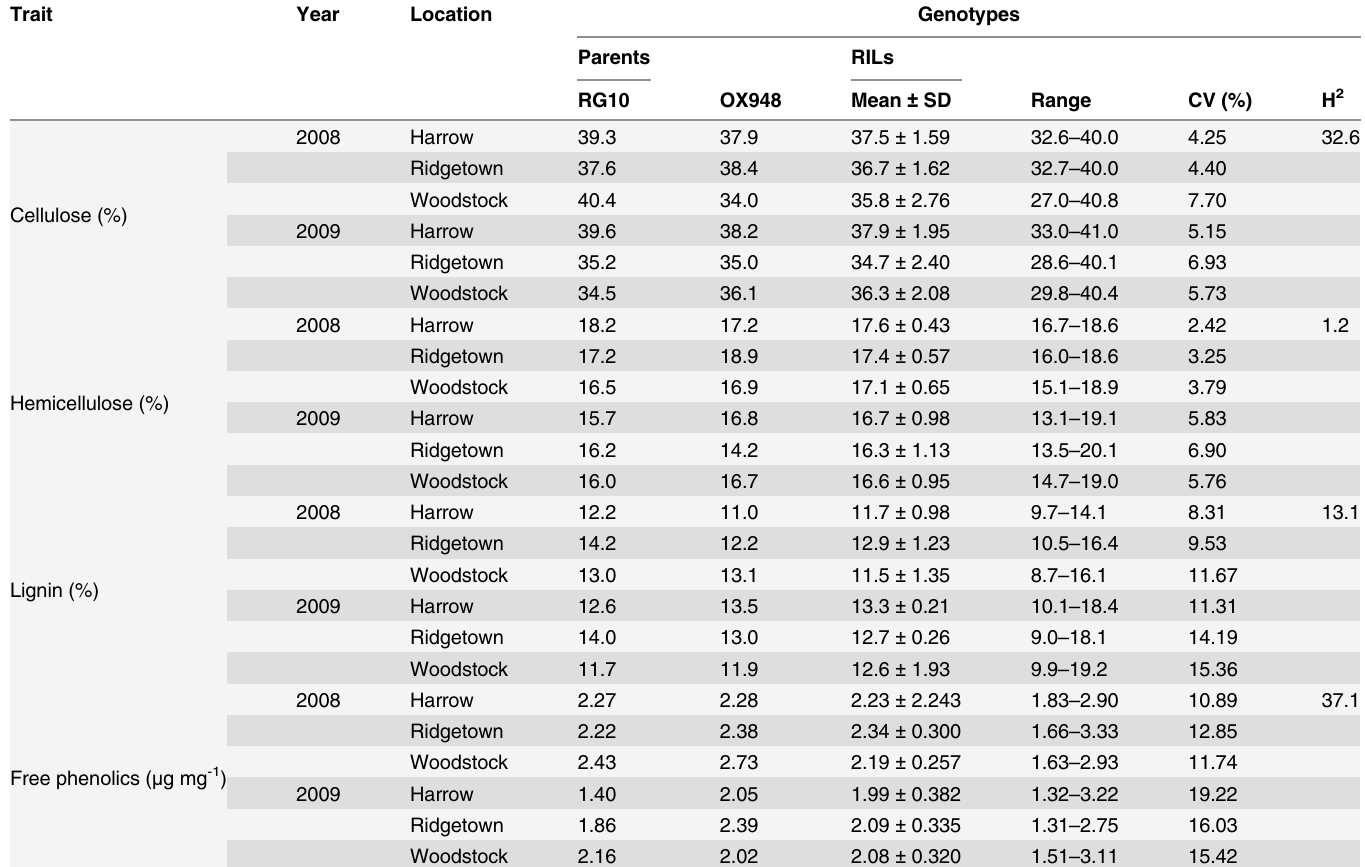
Table 1. Chemical composition of soybean stem fibers from parental genotypes and 50 selected RG10 x OX948 recombinant inbred lines (RILs). Trait